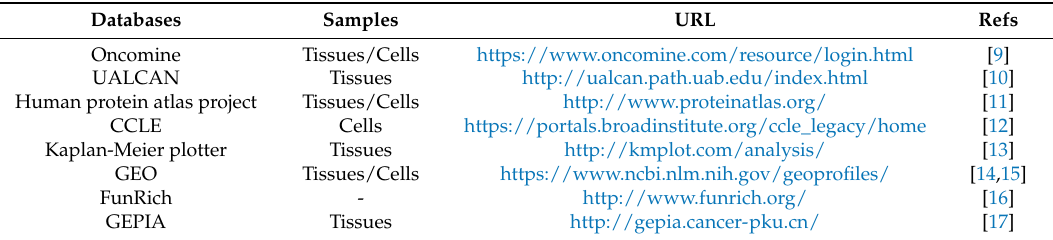
Table 1. The main bioinformatics tools used to analyze the functions of synuclein alpha ( SNCA ) in adenocarcinoma cells (ADC) biological